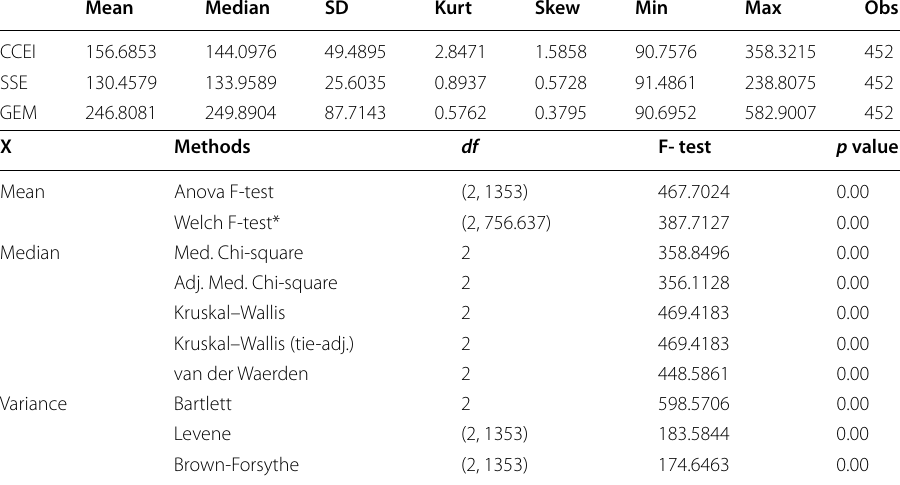
Table 5 Descriptive statistics of three indices